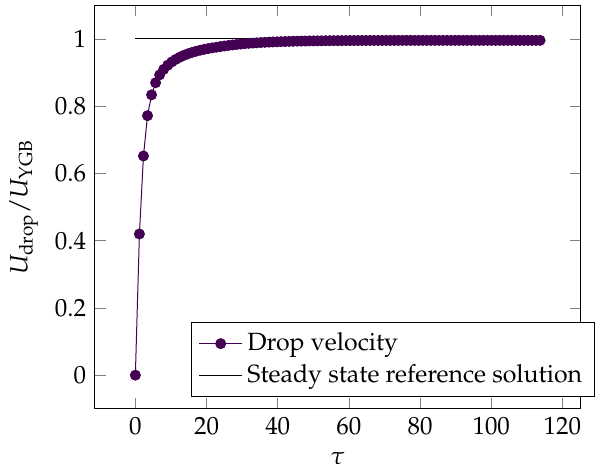
Figure 4. Drop velocity in a linear surfactant concentration gradient in comparison with the theoretical steady state solution from [38].